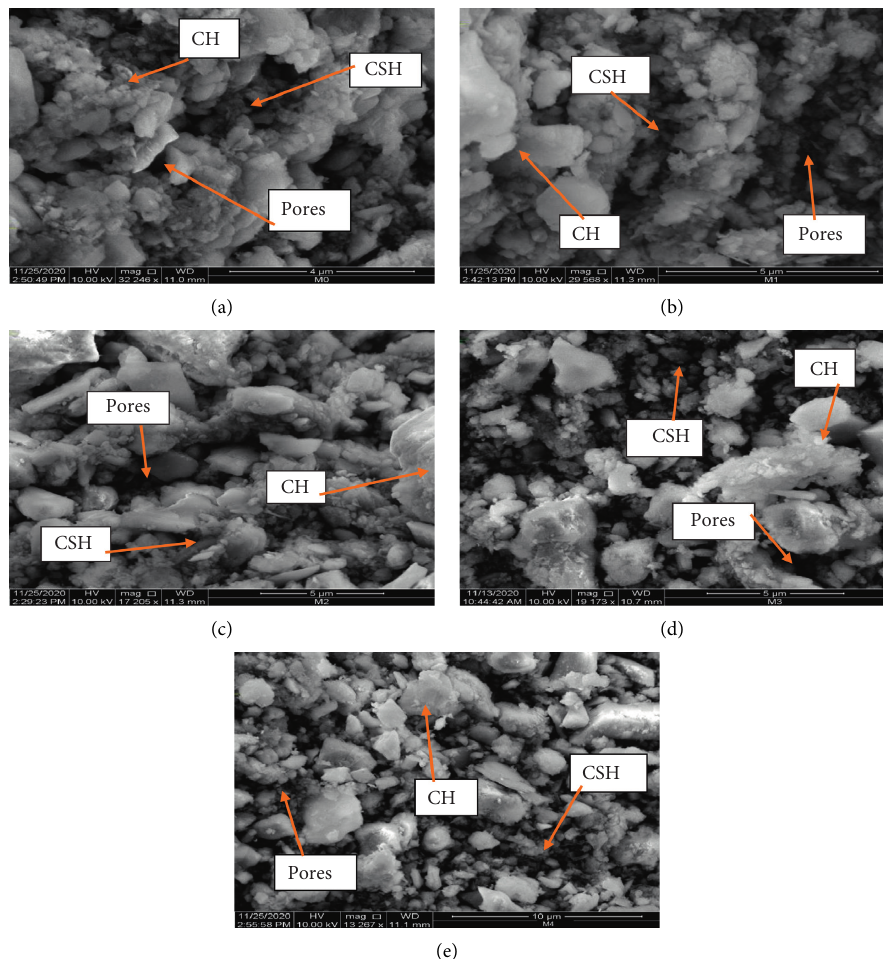
Figure 4: A SEM image of (a) 100% Ordinary Portland Cement hydration product, (b) 70% OPC+ 10% GGBS+15% WCP+5%